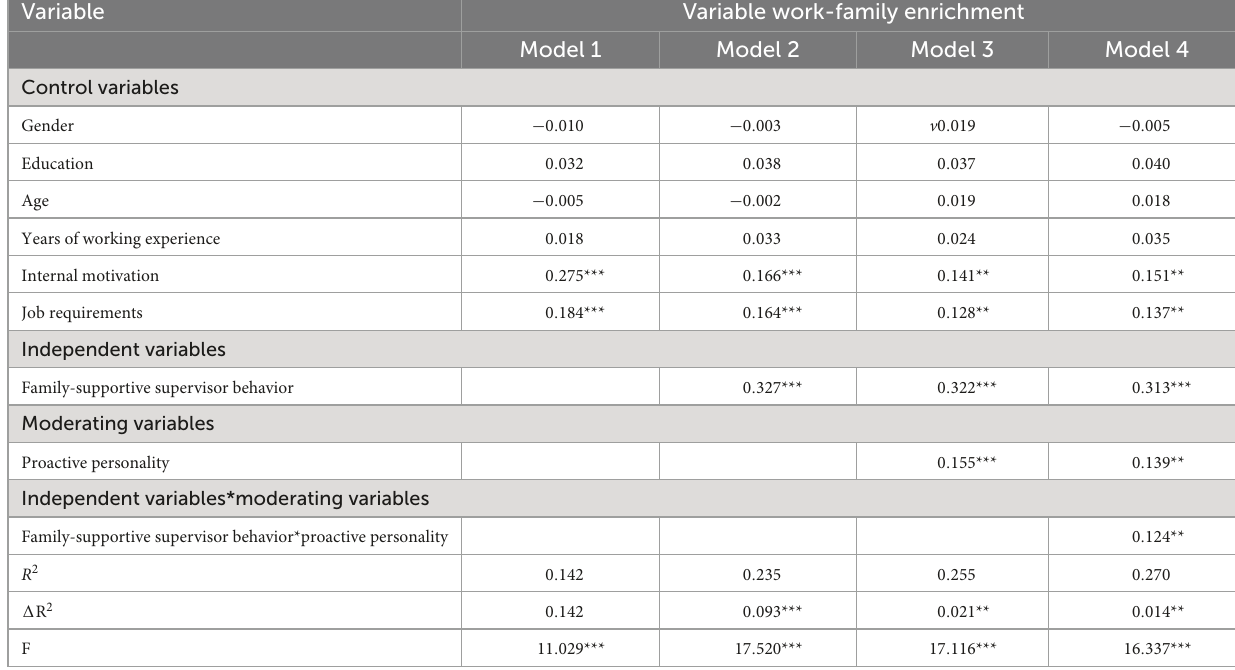
TABLE 5 Test results of hierarchical regression analysis (with work-family enrichment as the dependent variable).